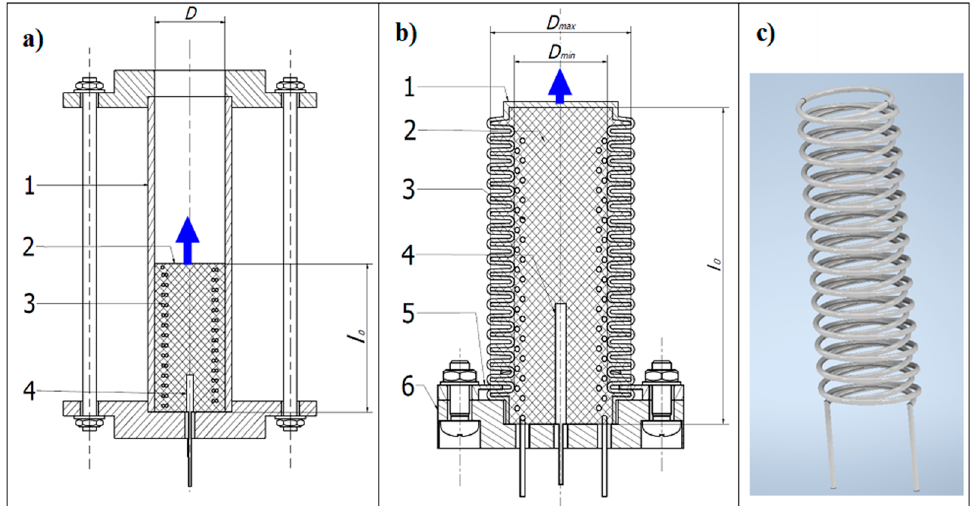
Figure 2. Construction of investigated unidirectional actuators: ( a ) Tube actuator where 1—polycarbonate tube, 2—composite 3—heater, i.e., spring-like wires—double coil, 4—thermocouple, 5—base; ( b ) bellow actuator where 1—bellow, 2—composite, 3—heater, 4—thermocouple, 5—mount of bellow, 6—base, 7—connecting wires; ( c ) heater.